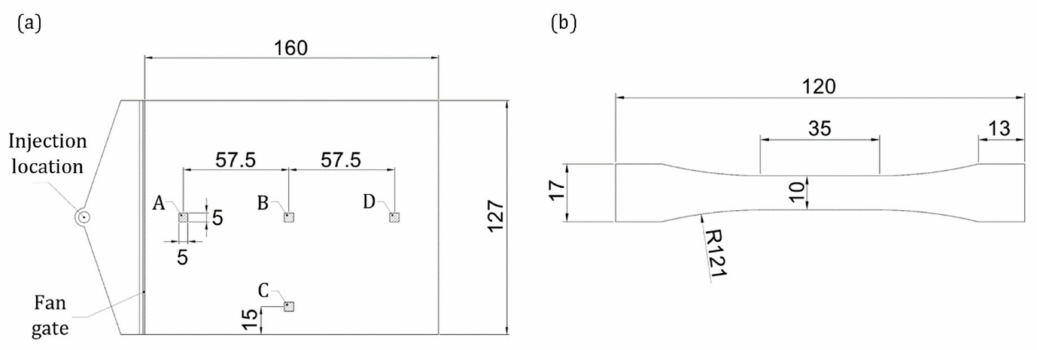
Figure 1. ( a ) Injection-molded plates and location of the investigated areas, and ( b ) cut-out tensile specimen